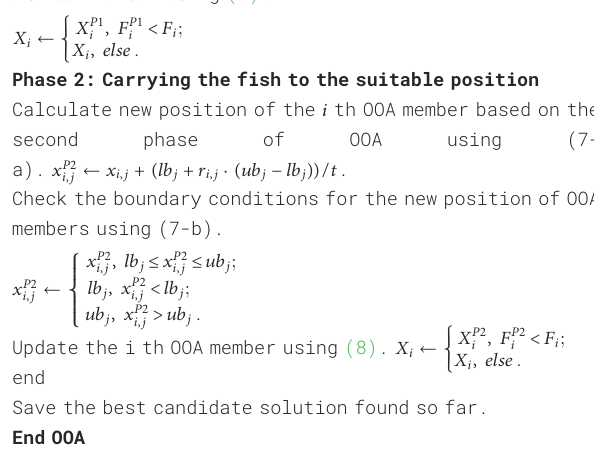
FIGURE 4 Boxplot of OOA and competitor algorithms in optimization of the CEC-2017 test suite ( D (cid:1) 30